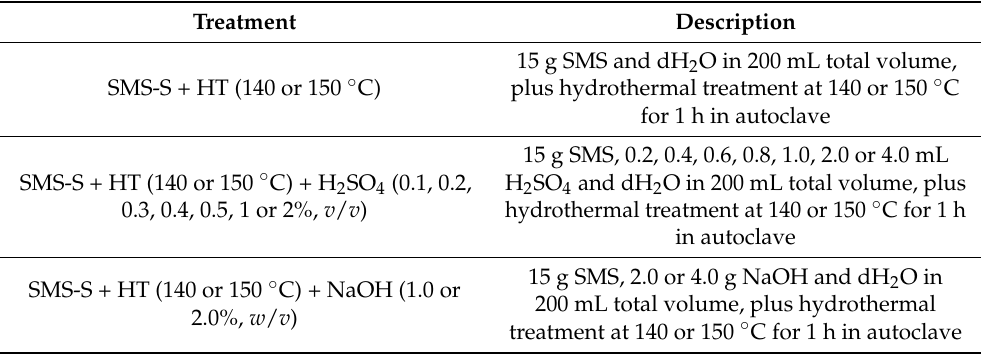
Table 2. Description of the applied pretreatment methods during optimization of the hydrolytic pro-